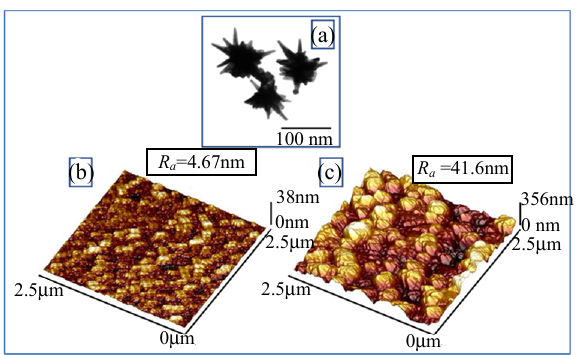
Fig. 2 Characterization of AuMs and fiber surface: (a) TEM image of AuMs nanoparticles with sharp edges; surface morphology of the thin gold film deposited on the multimode fiber core before (b) and after (c) grafting of AuMs.